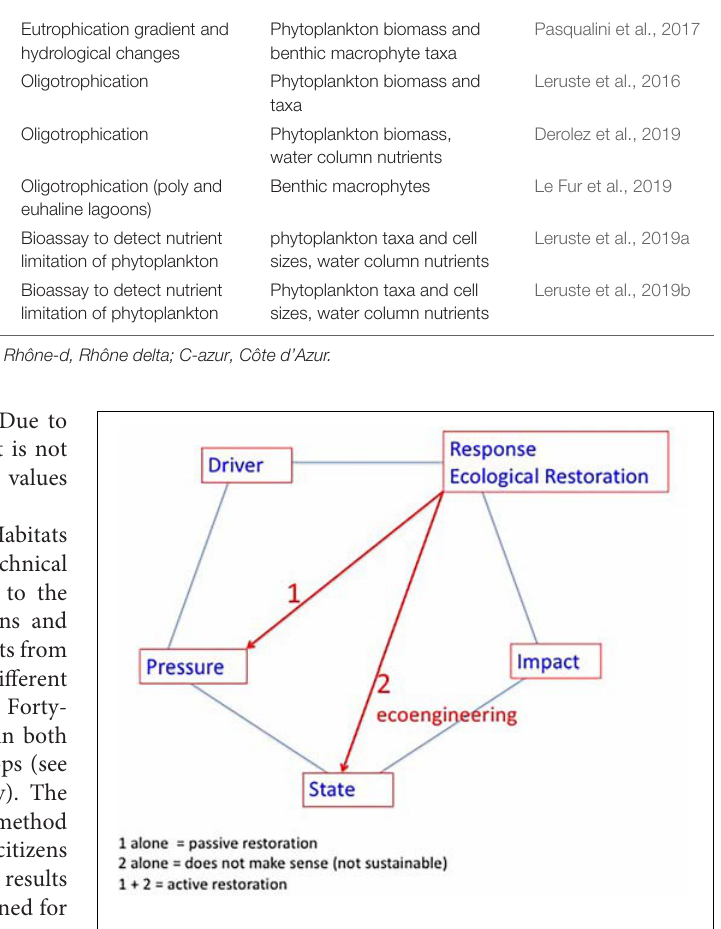
FIGURE 3 | Placing the Ecological Restoration practice in the D (drivers), P (pressures), S (state), I (impact), and R (response) framework. Accordingly, Ecological Restoration clearly is a societal response that targets 1) reducing the pressure on the ecosystem and 2) interfering directly with the ecosystem state through